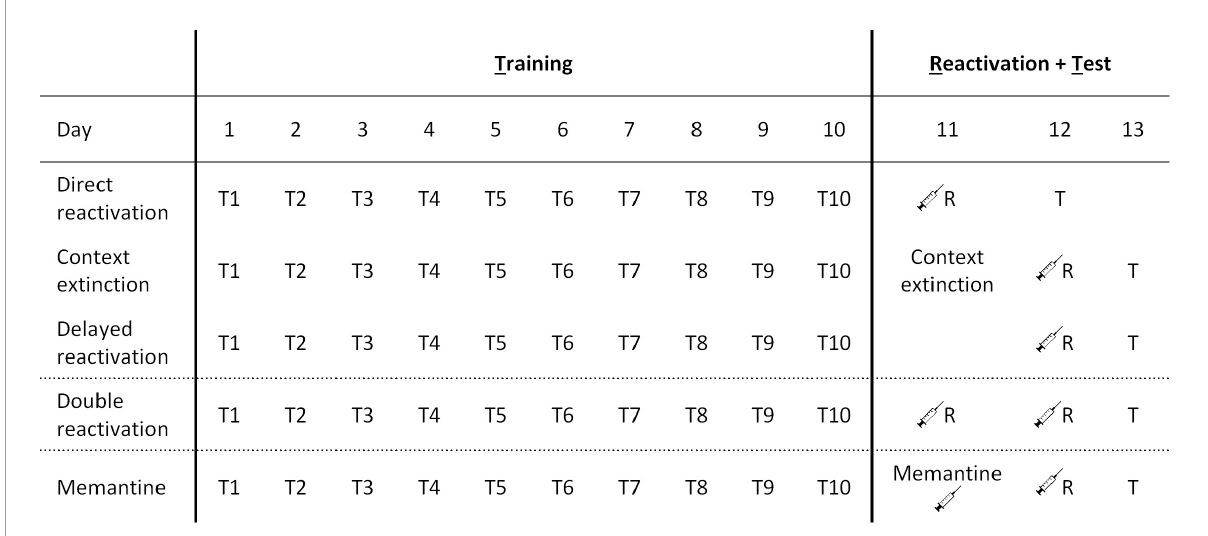
FIGURE1 Behavioral procedures across different experiments. The three reactivation procedures employed involved direct reactivation (VR5 reactivation on the day after the 10th day of training), context extinction (context extinction and FR5 reactivation sessions on consecutive days after the 10th day of training), and delayed reactivation (VR5 reactivation 2 days after the 10th day of training). In other experiments, the VR5 reactivation was repeated on two consecutive days (double reactivation), or there was an injection of memantine (or PBS vehicle) on the intervening day within the delayed reactivation